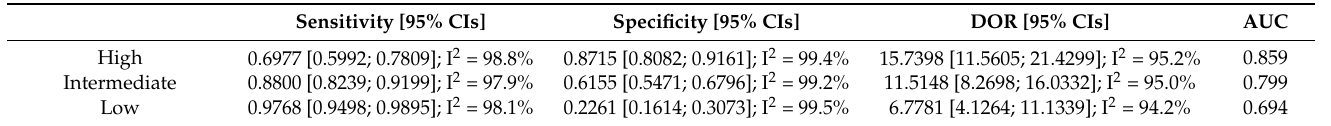
Table 3. Diagnostic efficacy and the ROC curves of ATA